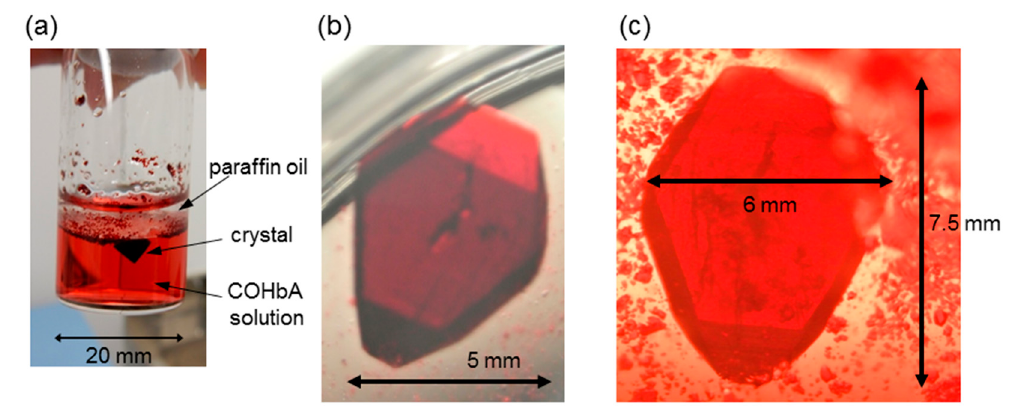
Figure 7. An extremely large-volume R-state COHbA crystal for XFH. ( a ) Example of the batch method using paraffin oil. Crystals appeared at the oil-solution interface ( b ) The COHbA crystal at 34 days after the first macroseeding setup. The crystal was washed to remove tiny crystals attached on the surface of the large crystal; ( c ) The same COHbA crystal grown to about 7.5 × 6 × 3 mm in size (~130 mm 3 ) at 193 days after the second macroseeding setup. This crystal was used for the measurement of XFH (see Figure 8a).